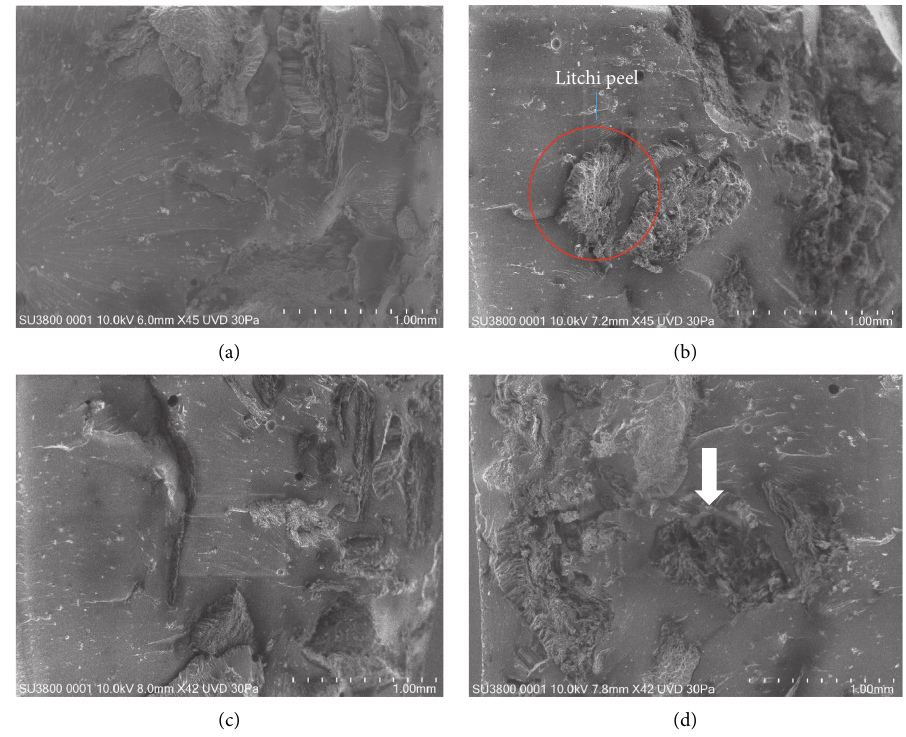
Figure 2: SEM figure of composite/litchi peel (LP): (a) 10 wt% LP, (b, d) 20 wt%, and (c) 30